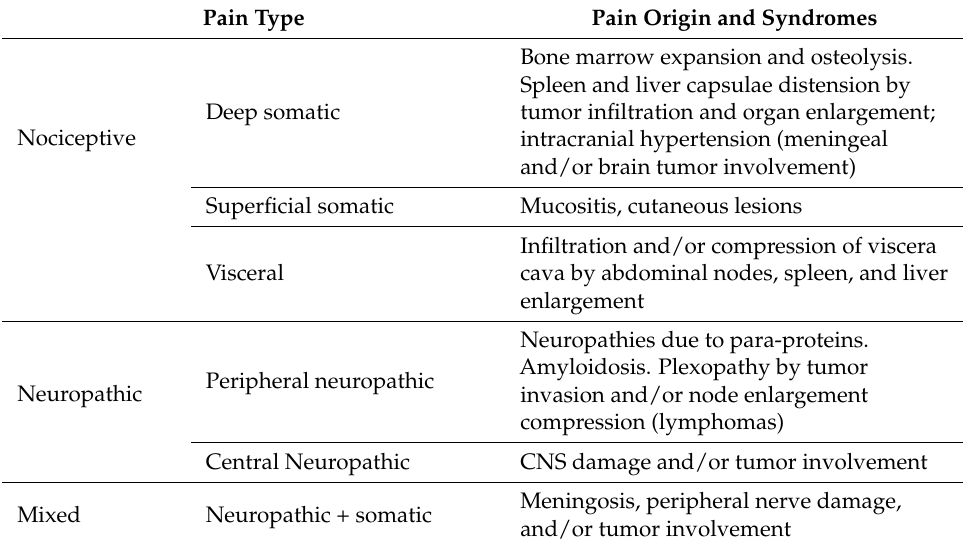
Table 2. Most common pain syndromes in patients with hematological malignancies. Pain Type Bone marrow expansion and